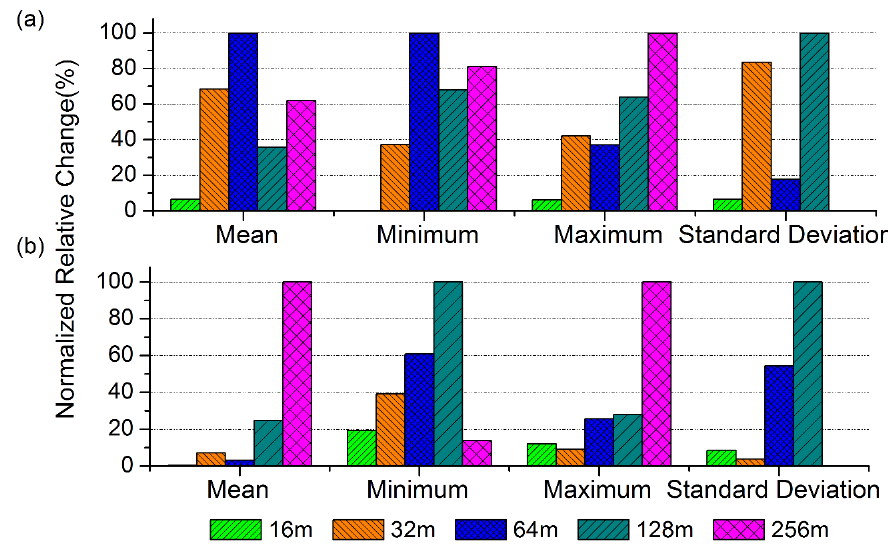
Figure 6. The normalized relative change of the mean, minimum, maximum, and standard deviation of WRT (dry weight of roots) as the spatial scale of LAI (leaf area index) information changed from 8 m to 16 m, 32 m, 64 m, 128 m, and 256 m in the two study areas: ( a ) Area A and ( b ) Area